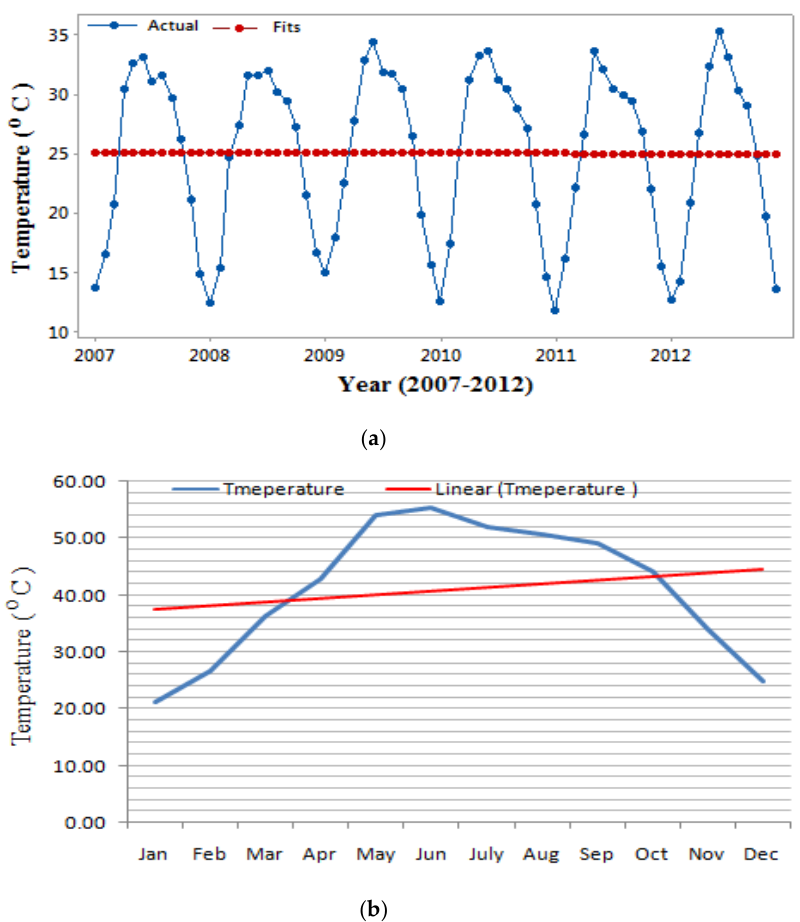
Figure 7. ( a ) Monthly time series of temperature in Lahore City, 2007–2012. ( b ) Seasonal time series of temperature in Lahore City, 2007–2012.